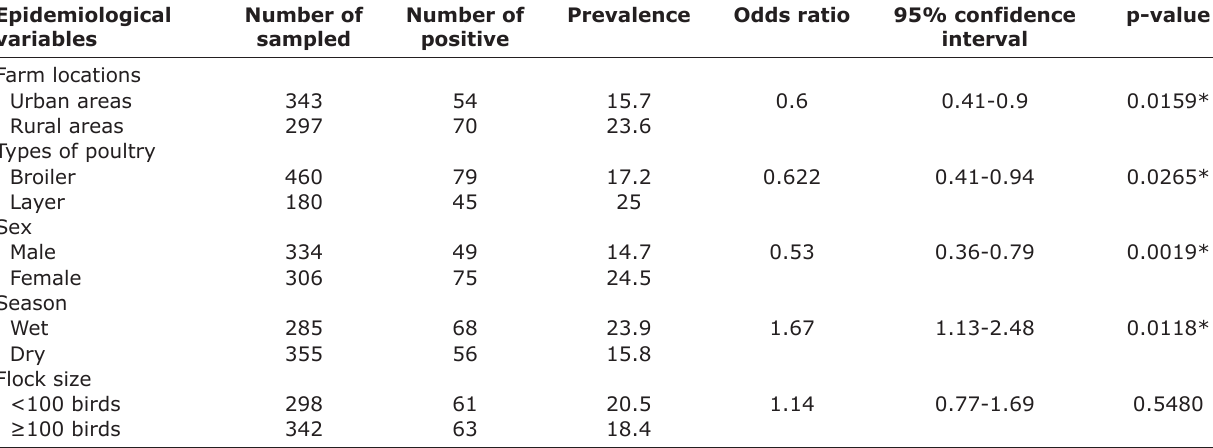
Table-2: Prevalence of thermophilic Campylobacter infection in poultry farms (n=60) surveyed in Nsukka agricultural zone, Nigeria. Epidemiological variables